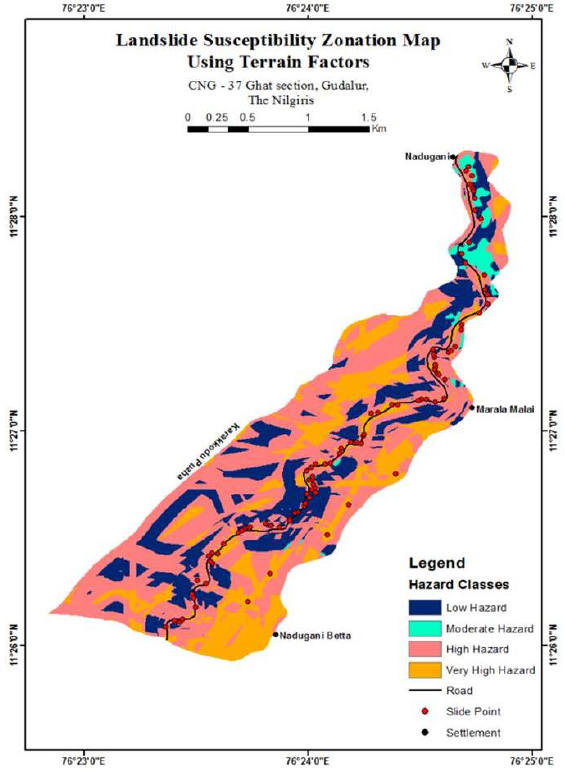
Figure 6 LSZ map using terrain factors 4 CONCLUSION